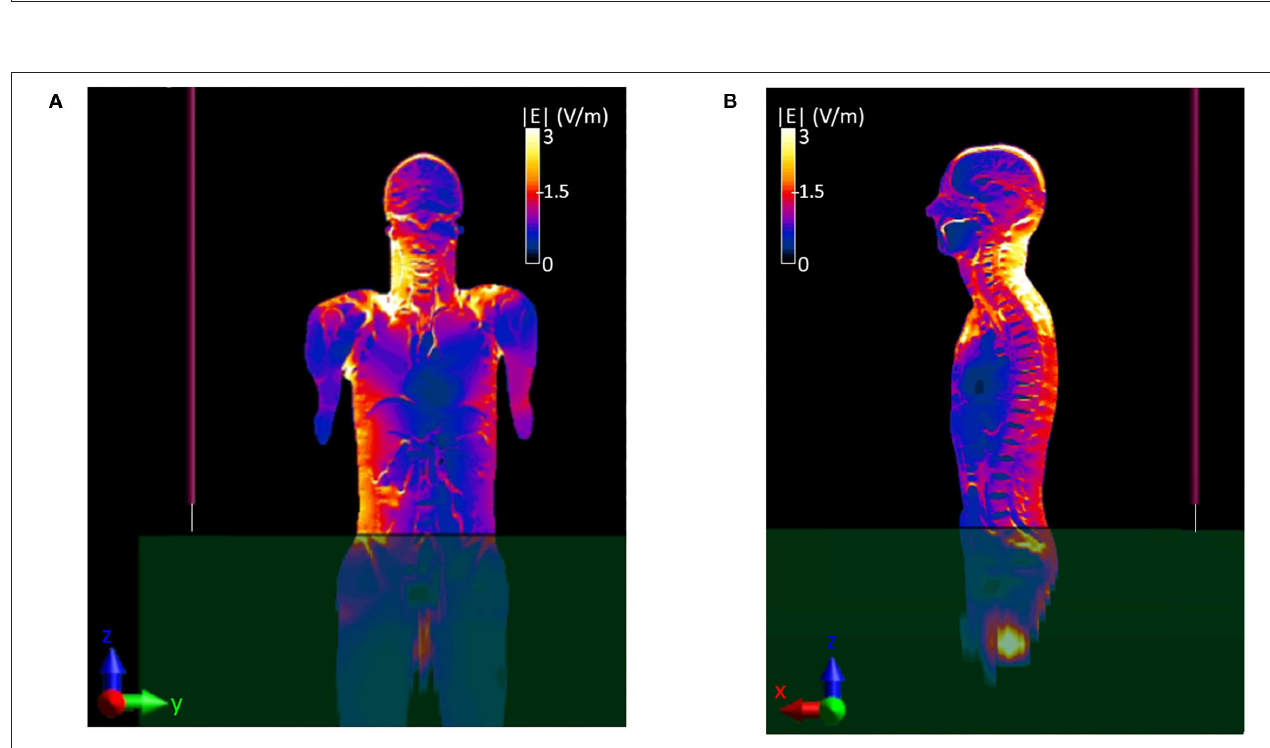
FIGURE 4 | Distribution of the E-field induced inside the virtual body model Duke. (A) Coronal or frontal plane-YZ, (B) sagittal or lateral plane-XZ.